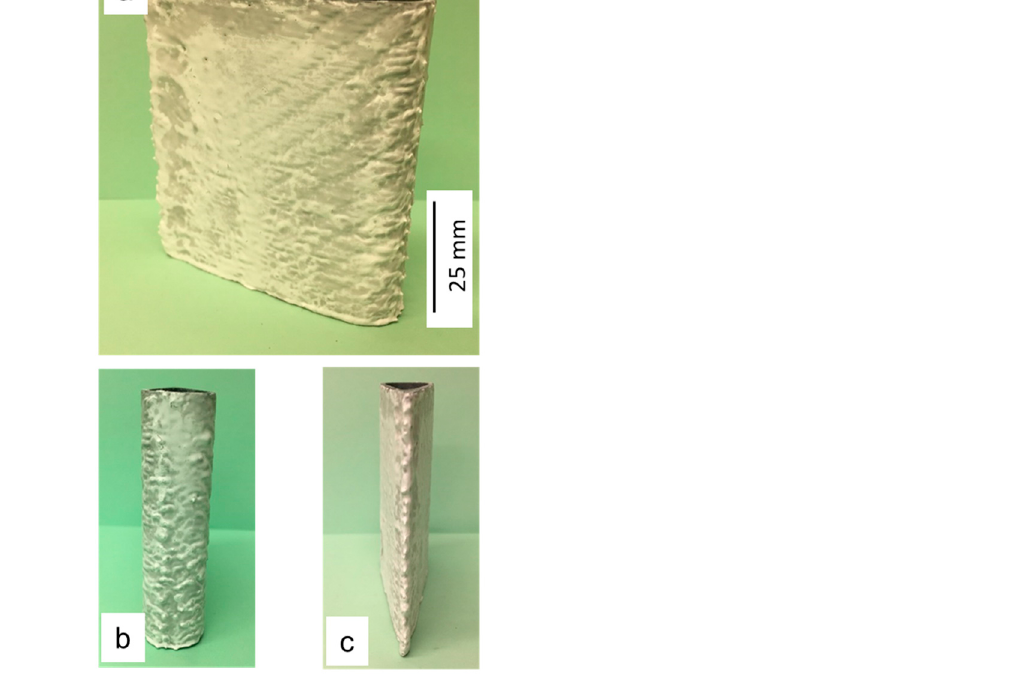
Figure 3. EBC-coated CMC airfoil via spin-dipping: ( a ) flat surface; ( b ) leading edge; ( c ) trailing edge.